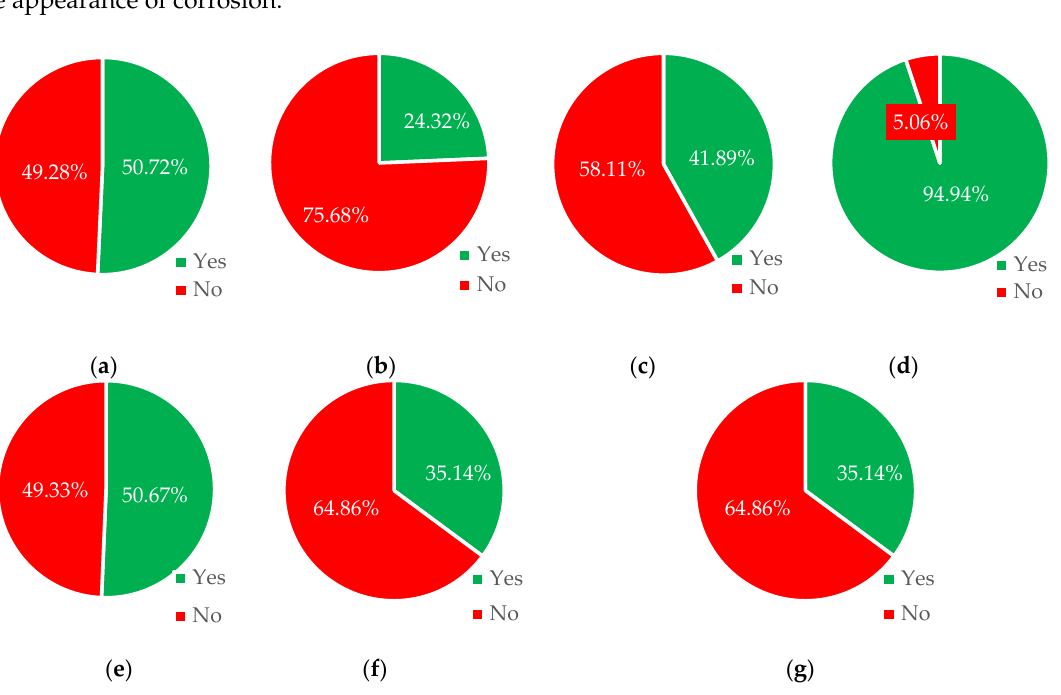
Figure 3. Percentage of the possibility of using installation materials at which corrosion of individual installation materials will not occur. Type of installation material: ( a ) copper, ( b ) galvanized iron, ( c ) stainless steel, ( d ) acid-resistant steel, ( e ) cast iron, ( f ) low-alloy steel, and ( g ) nonalloy